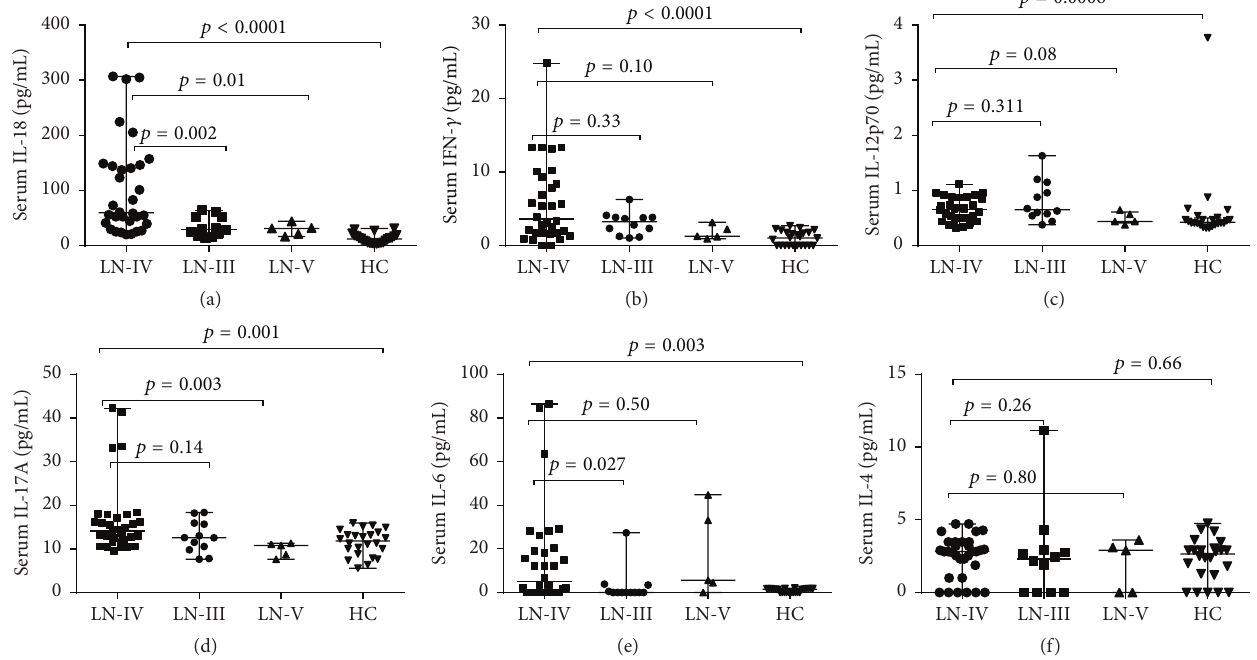
Figure 1: Comparison of serum levels Th1 cytokines (IFN- 𝛾 , IL-18, and IL-12p70), Th2 cytokine (IL-4), and Th17 cytokines (IL-17A and IL-6) in the LN classes and healthy control (HC). (a) IL-18 was significantly elevated in lupus nephritis-IV compared to III ( 𝑝 = 0.002 ), LN-V (0.01), and HC ( 𝑝 < 0.0001 ). (b) Serum IFN- 𝛾 level was high in LN-IV when compared with healthy control ( 𝑝 < 0.0001 ), whilst there are no differences among LN-III and LN-V. (c) Serum level of IL-12p70 was significantly higher in lupus nephritis-IV in comparison with HC ( 𝑝 = 0.0006 ), but there are no significant differences with LN-III and LN-V. (d) Serum IL-17A was elevated in LN-IV when compared to LN-V ( 𝑝 = 0.003 ) and healthy control ( 𝑝 = 0.001 ). (e) IL-6 was increased in LN-IV when compared to LN-III and healthy control. (f)